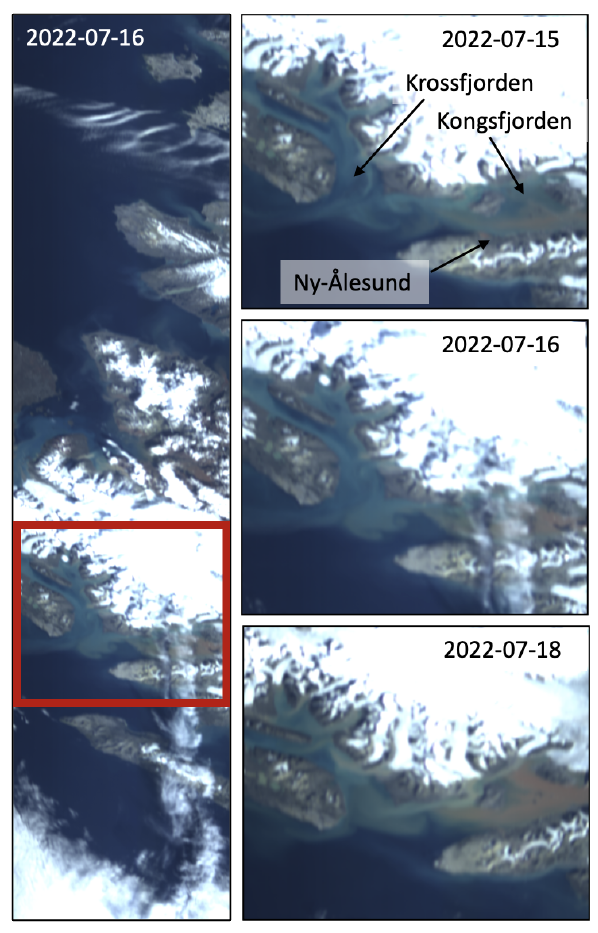
Figure 4. RGB render of HYPSO-1 captures over Svalbard, outside of Ny-Ålesund and Kongsfjorden from July 2022. The bands used for the RGB composite representation are 602.5 nm, 565 nm and 498.4 nm,